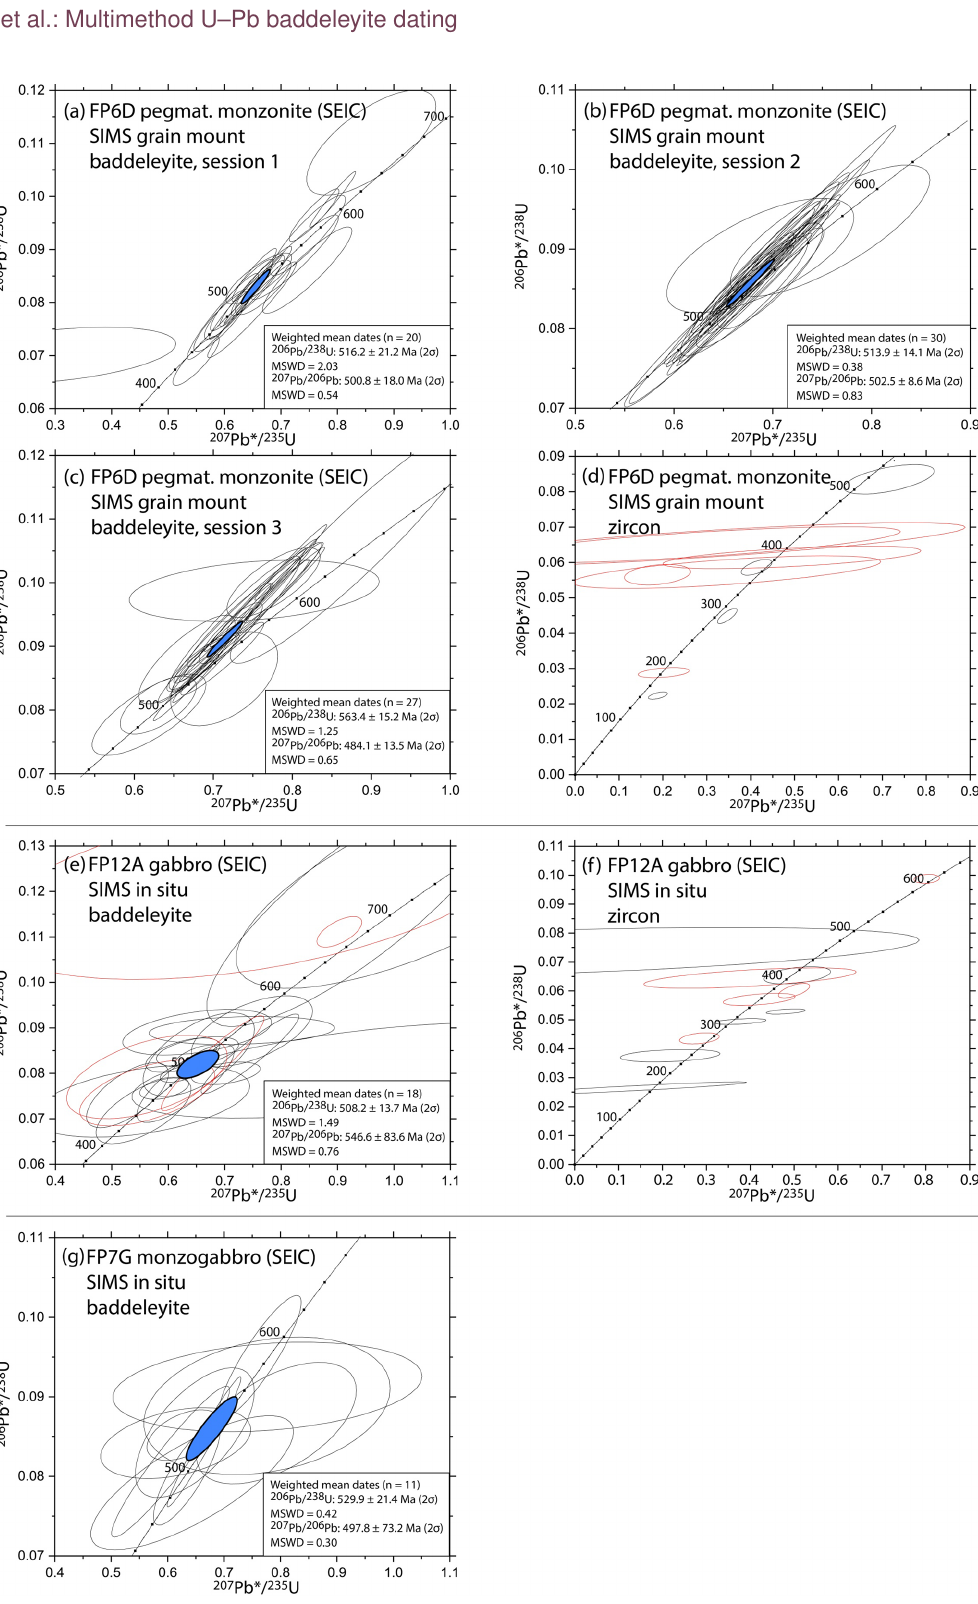
Figure 6. SIMS U–Pb baddeleyite and zircon results for SEIC samples. Ellipses in red represent analyses of baddeleyite with zircon inclu- sions (e) or zircon analyses with < 90% radiogenic 206 Pb (d, f) . Error ellipses of individual analyses are 1 σ , whereas the weighted mean ellipse (blue) is enlarged to 2 σ